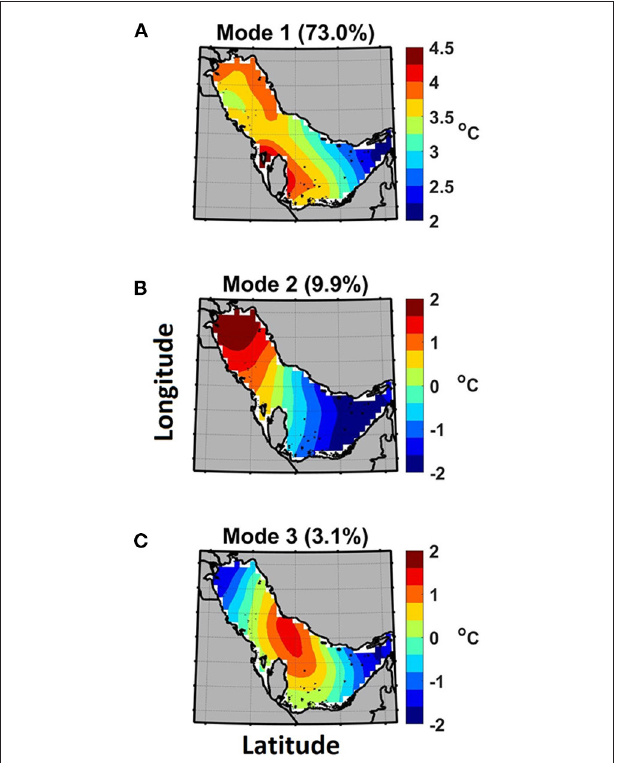
FIGURE 10 | Gulf EOF of first three SST modes for 1982–2020. EOF: empirical orthogonal